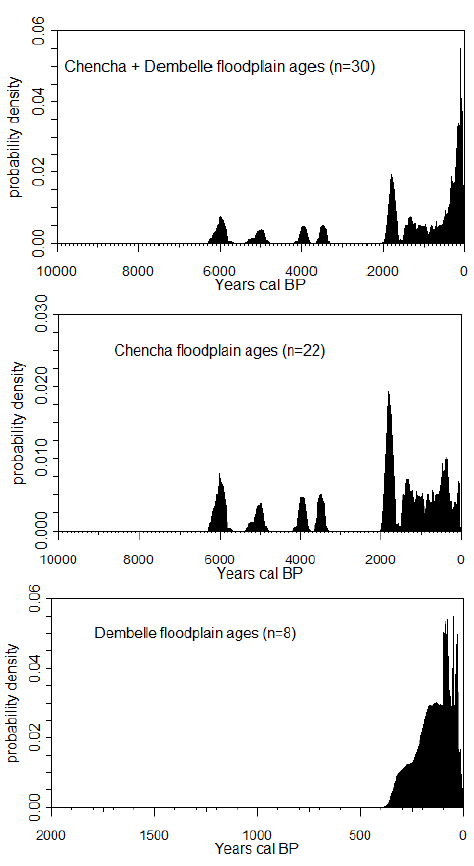
Figure 7. CPF of radiocarbon ages of the datable materials for Chencha and Dembelle floodplains. Probability was divided by the probability of 100 equally spaced ages and corrected for the biases.